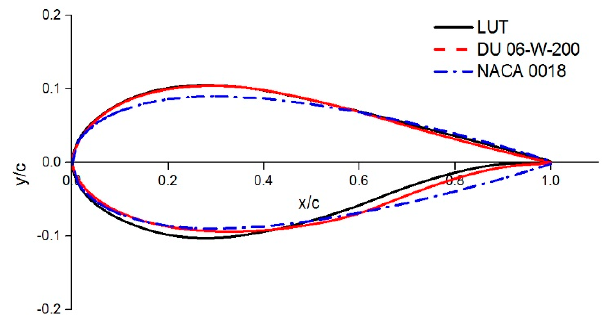
Figure 4. The profiles of the three airfoils. The profiles of the NACA 0018 and DU06-W-200 models come from the material specified on the website [28]. As shown in this Figure, the marks in black, red, and blue represent the profiles of the LUT, DU06-W-200, and NACA 0018 airfoils, respectively.